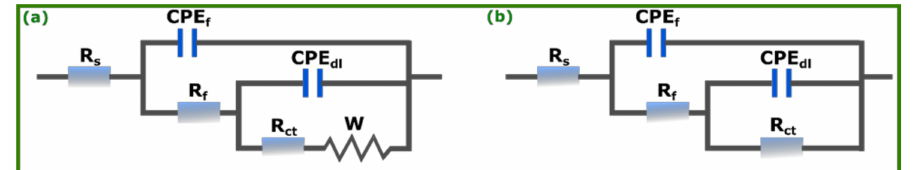
Figure 2. Electrical equivalent circuits used to fit the EIS data; ( a ) blank medium, ( b ) with